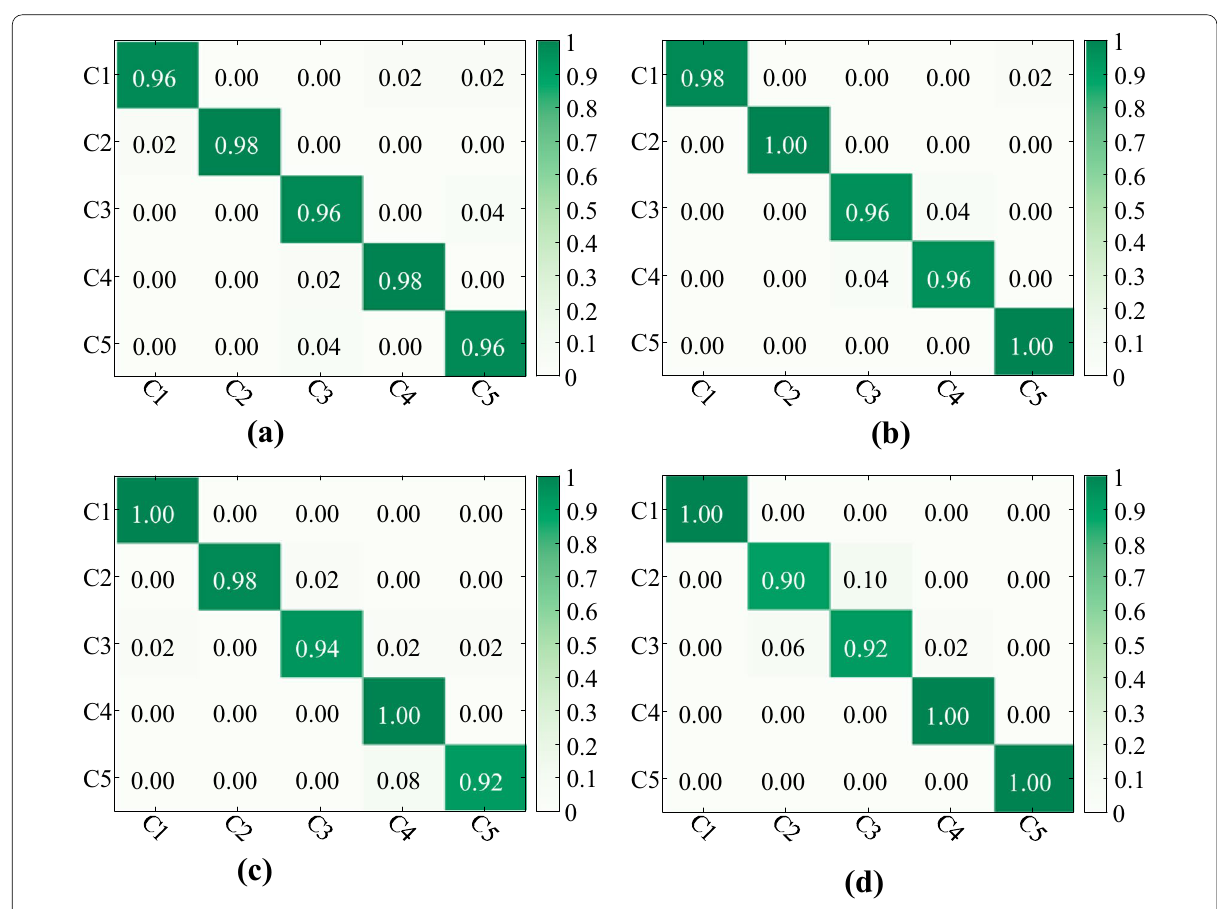
Figure 11 Confusion matrix of NMPT on transferring datasets with different loads